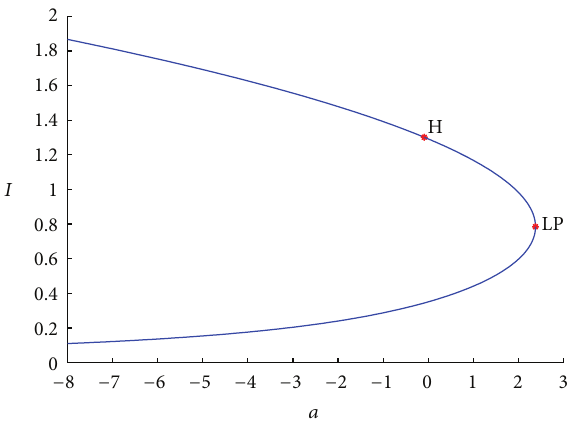
Figure 3: Bifurcation curves in (𝑎, 𝐼) plane by fixed 𝐴 = 2, 𝑑 = 0.1, 𝛽 = 0.8, 𝑏 = 2.4, 𝜖 = 0.6, 𝛾 = 0.2 , where H denotes the Hopf bifurcation, LP is the limit point (flod) bifurcation.